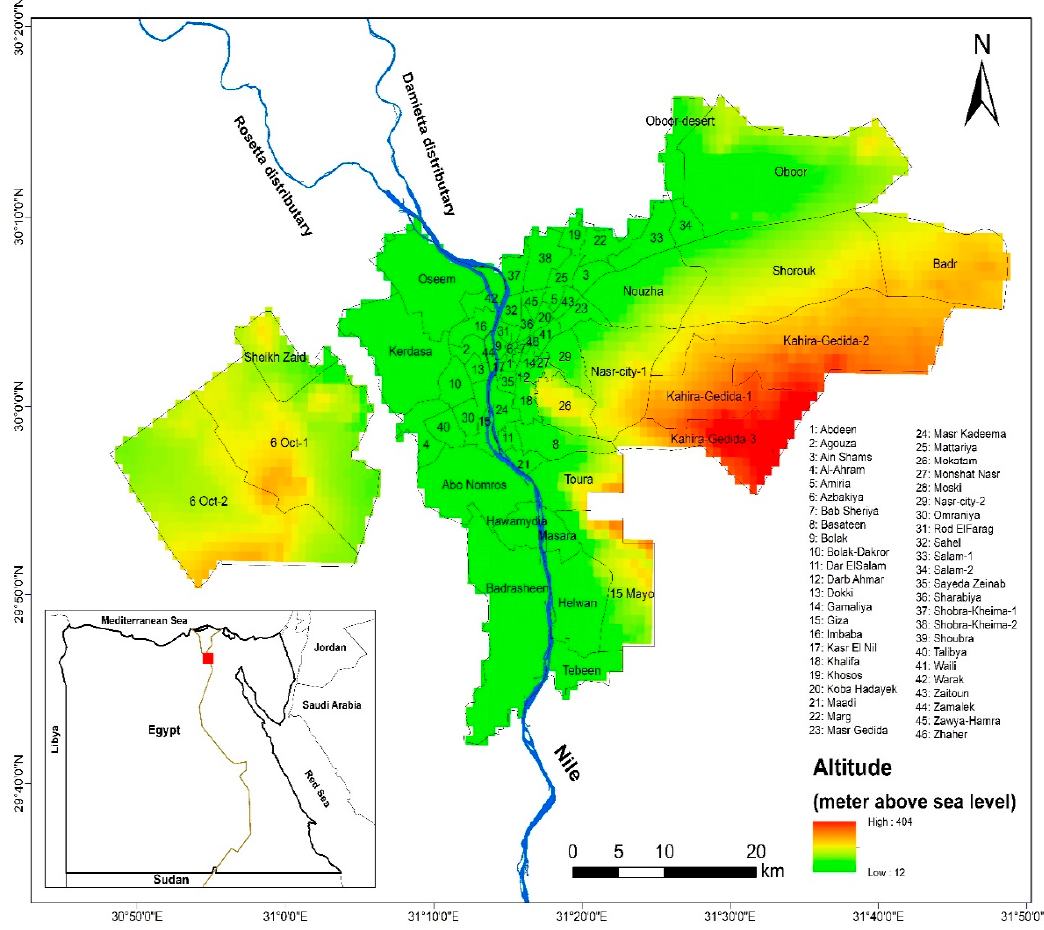
Figure 1. Location of Greater Cairo, its topography, and main administrative divisions. Topography was presented based on the SRTM GL1 digital elevation model (DEM) EM at 30-m spatial resolution (https://lpdaac.usgs.gov/products/srtmgl1v003/).